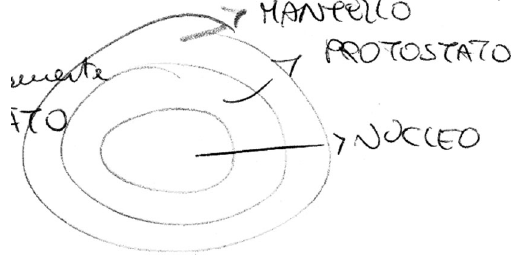
FIG. 4. Typical naïve student sketch of a star ’ s internal structure. Translation of Italian labels, from top to bottom: mantle, first layer,